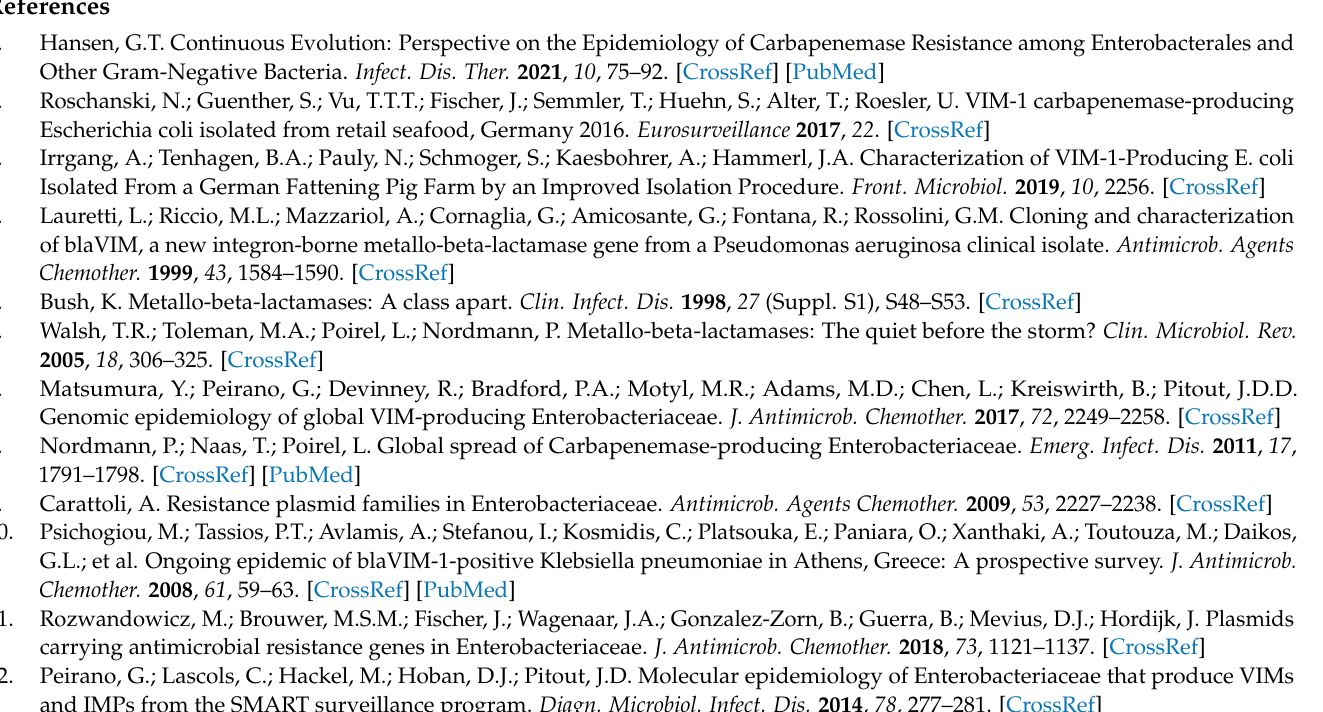
Table S2: BLAST search results for E. coli PBIO2728 plasmid pPBIO2728_VIM-1 against the NCBI nucleotide database sorted by query coverage (descending). Highlighted entries are included in the analyses of this study. Figure S1: Plasmid profile analysis of all investigated isolates. Strain names are colored according to species as in Figure